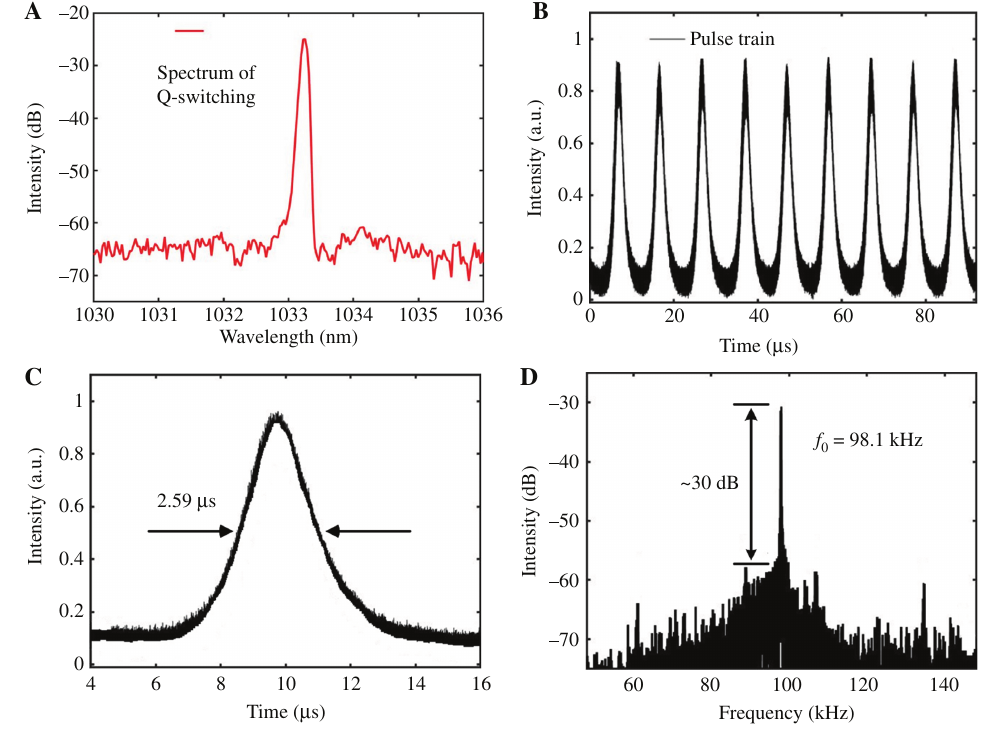
Figure 8: Stable Q-switched operation at the pump power of 300 mW. (A) Optical spectrum; (B) temporal sequences of output pulse recordings; (C) single-pulse profile of the Q-switched pulse train; (D) RF spectrum over a 100 kHz span with resolution bandwidth of 10 Hz.